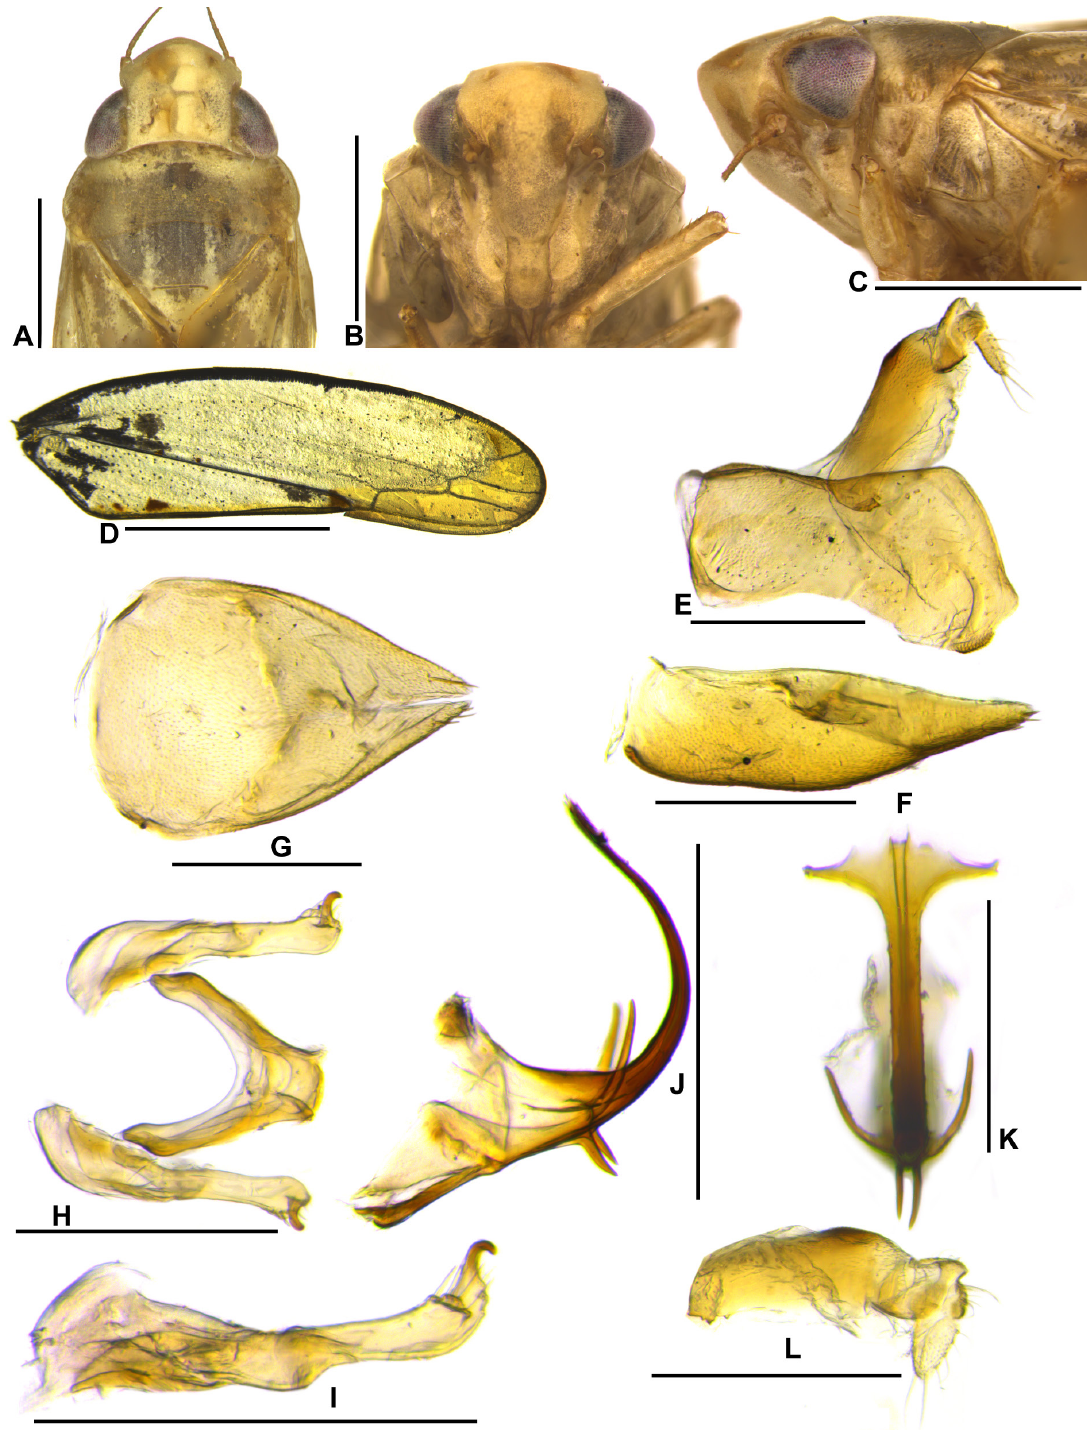
Fig. 5. Takiyaella coelhomarquesae gen. et sp. nov., ♂, holotype (DZUP-083605). A . Head and thorax, dorsal view. B . Head, frontal view. C . Head and thorax, lateral view. D . Forewing. E . Pygofer and anal tube, lateral view. F . Valve and subgenital plate, lateral view. G . Valve and subgenital plate, ventral view. H . Styles and connective, dorsal view. I . Style, lateral view. J . Aedeagus, lateral view. K . Aedeagus, caudal view. L . Anal tube, lateral view. Scale bars: A–C = 1.0 mm; D = 2.0 mm; E–J, L = 0.5 mm; K = 0.4